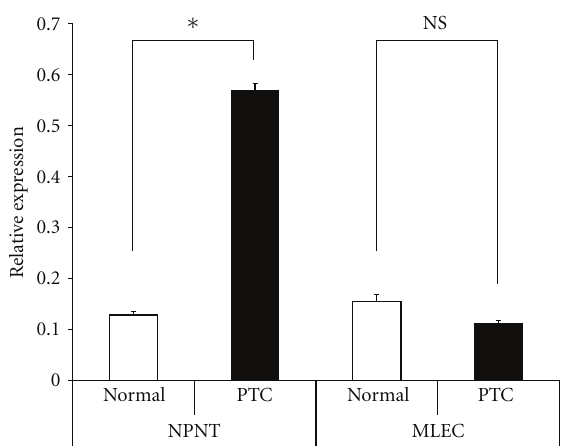
Figure 4: Gene expression of new candidate markers (NPNT and MLEC) in normal thyroid tissue and PTC. Gene expression of NPNT was significantly higher in PTC when compared with normal thyroid tissue. However, expression of MLEC showed no significant di ff erences (Normal: normal thyroid tissue, PTC: Papillary thyroid carcinoma, ∗ P < 0 . 05, NS: not significant, Bar: 1